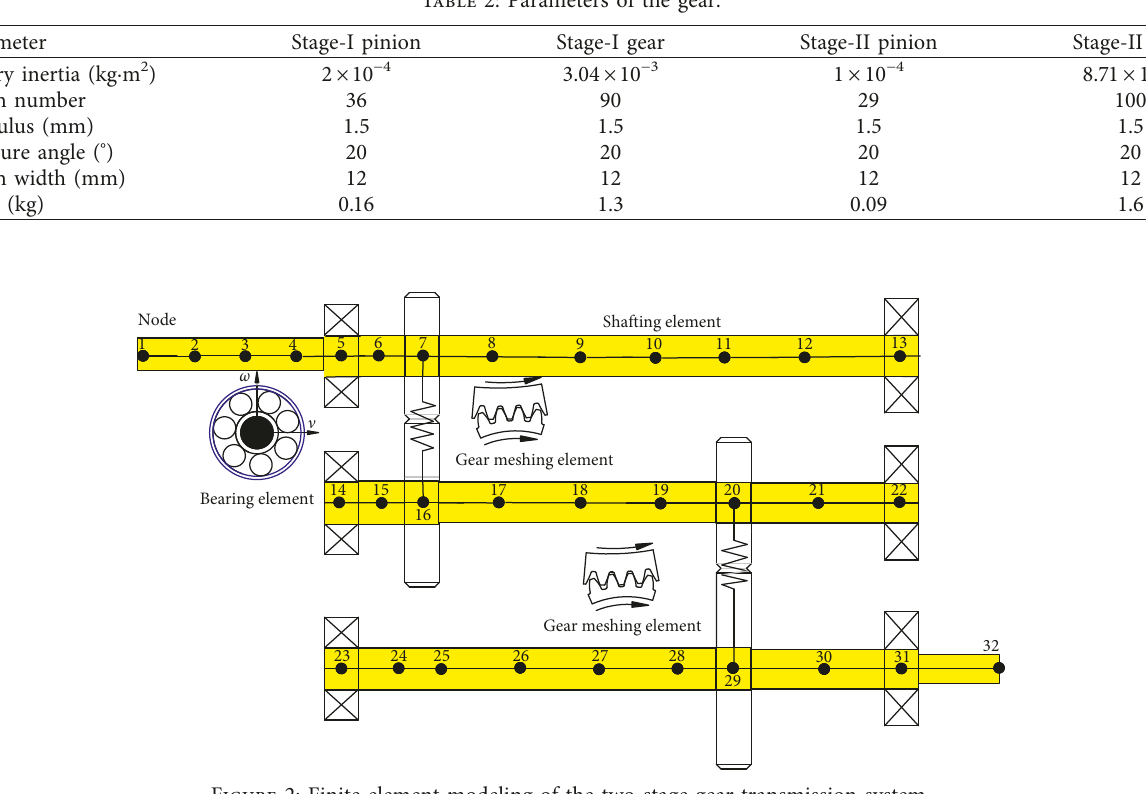
Figure 2: Finite element modeling of the two-stage gear transmission system.